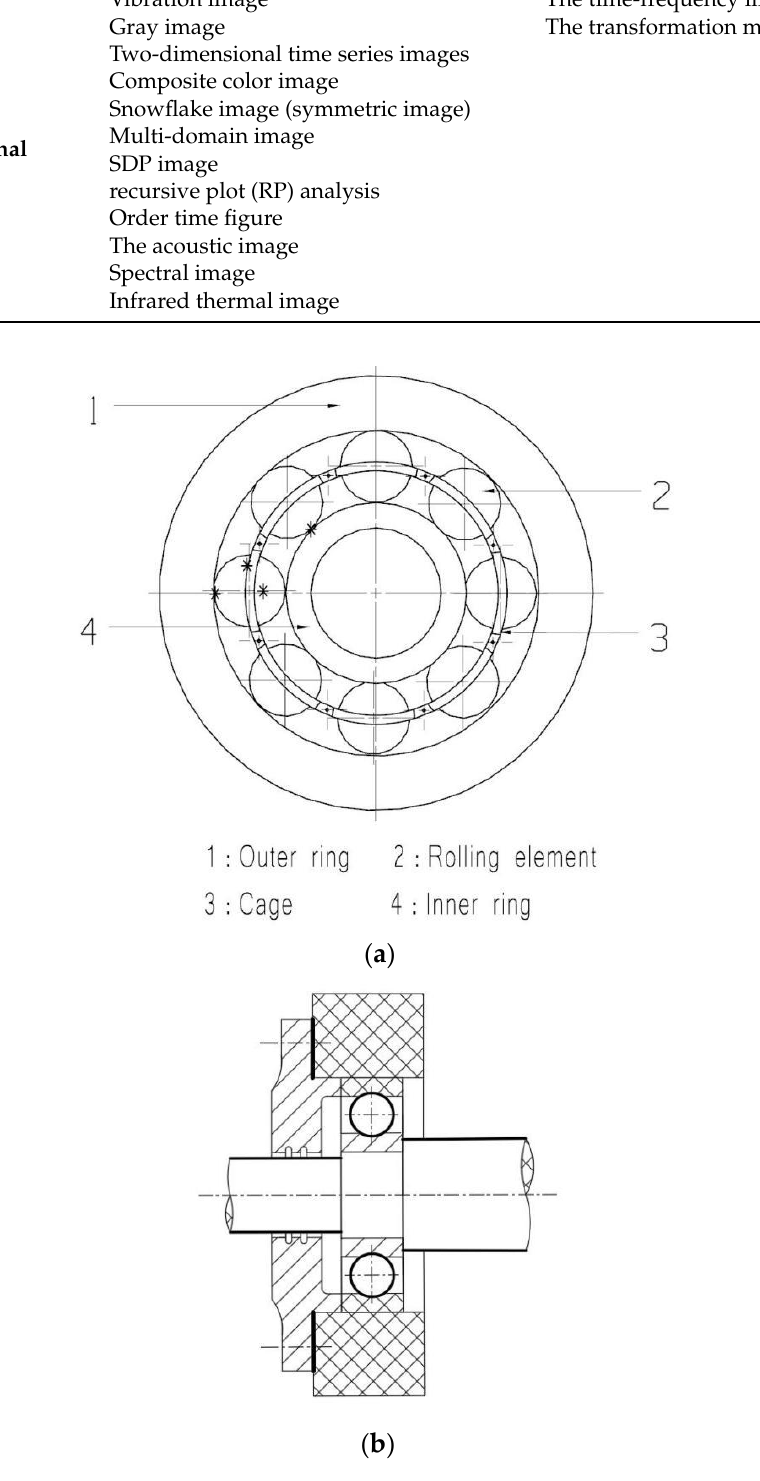
Figure 2. We take deep-groove ball rolling bearings as an example. ( a ) Rolling bearing plane view, where * marks the fault location. Taking deep-groove ball rolling bearings as an example. ( b ) Lateral section view of rolling bearing and shaft in assembly. Table 1. A list of internal and external sensors with one-dimensional and two-dimensional signals.